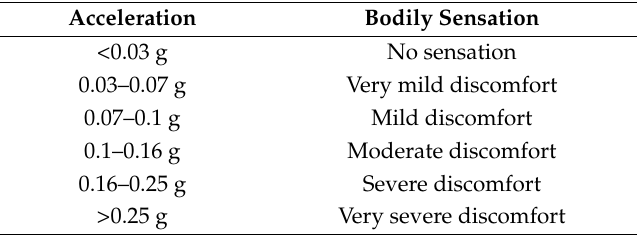
Table 1. Relationship between acceleration and bodily